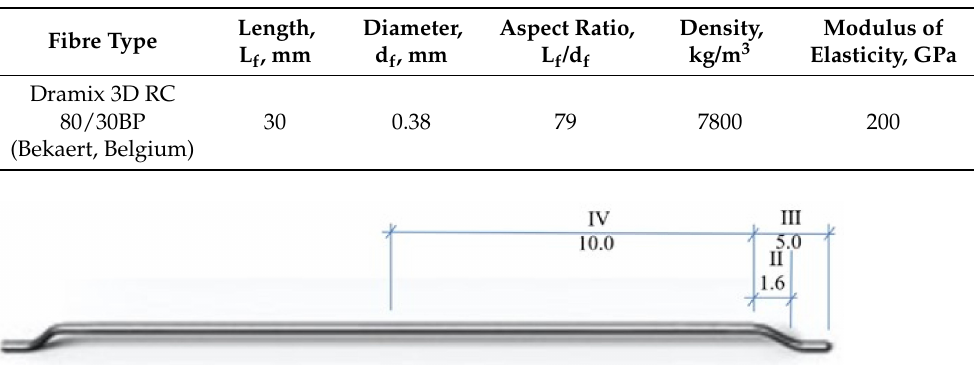
Figure 1. Geometry of steel fiber Dramix 3D RC 80/30BP (supplier’s data).